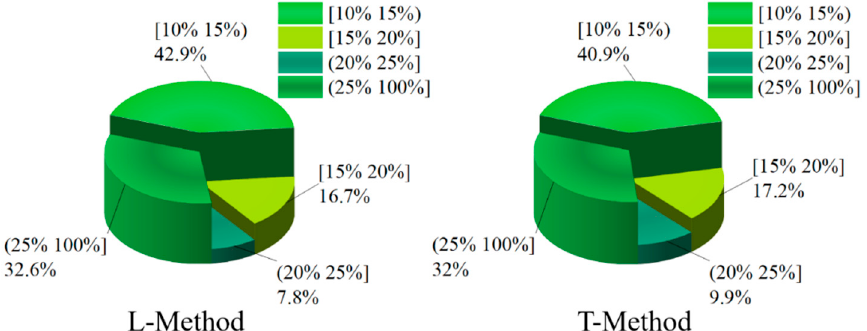
Figure 16. Ratio of right-front wheel slip under different control strategies.